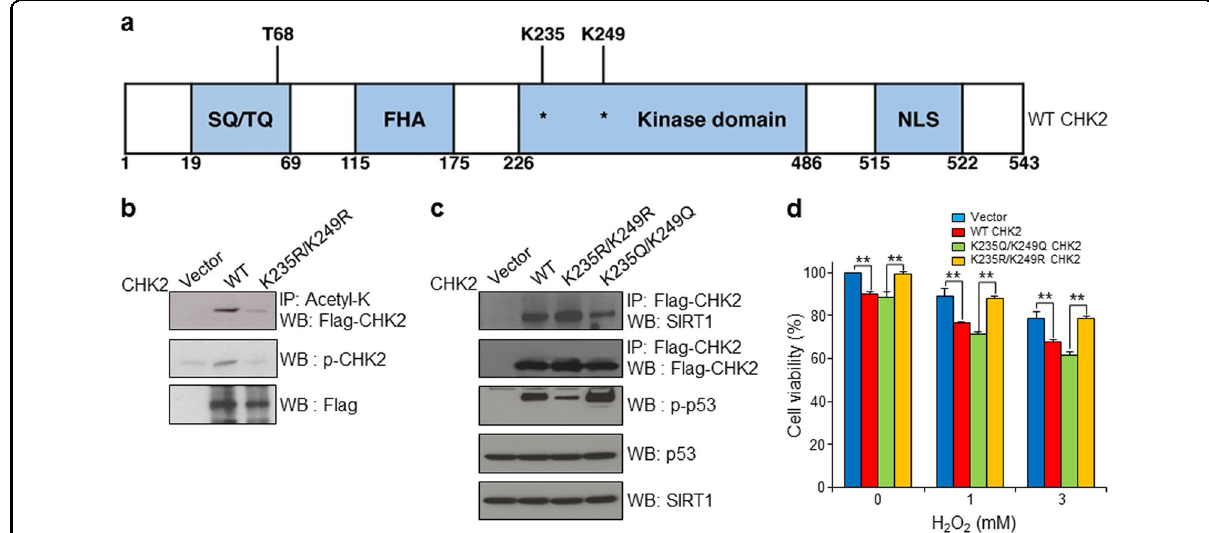
Fig. 4 K235 and K249 residues of CHK2 are deacetylated by SIRT1. a Domain structure of CHK2. b The acetylation and phosphorylation levels of CHK2 were largely decreased by K235R/K249R substitution (KR) of CHK2 in HCT116 cells. c K235Q/K249Q changes in CHK2 decreased the interaction between CHK2 and SIRT1 and increased the level of p-p53 compared with WT CHK2 in HCT116 cells. d Under oxidative stress conditions, WT CHK2 and K235Q/K249Q CHK2 enhanced cell death but K235R/K249R CHK2 did not in HCT116 cells. IP immunoprecipitation, WB western blot. Data represent the mean ± SD (* P < 0.05, ** P < 0.01, ns: not signi fi cant, Student ’ s t -test). Shown are single experimental results from triplicates that are